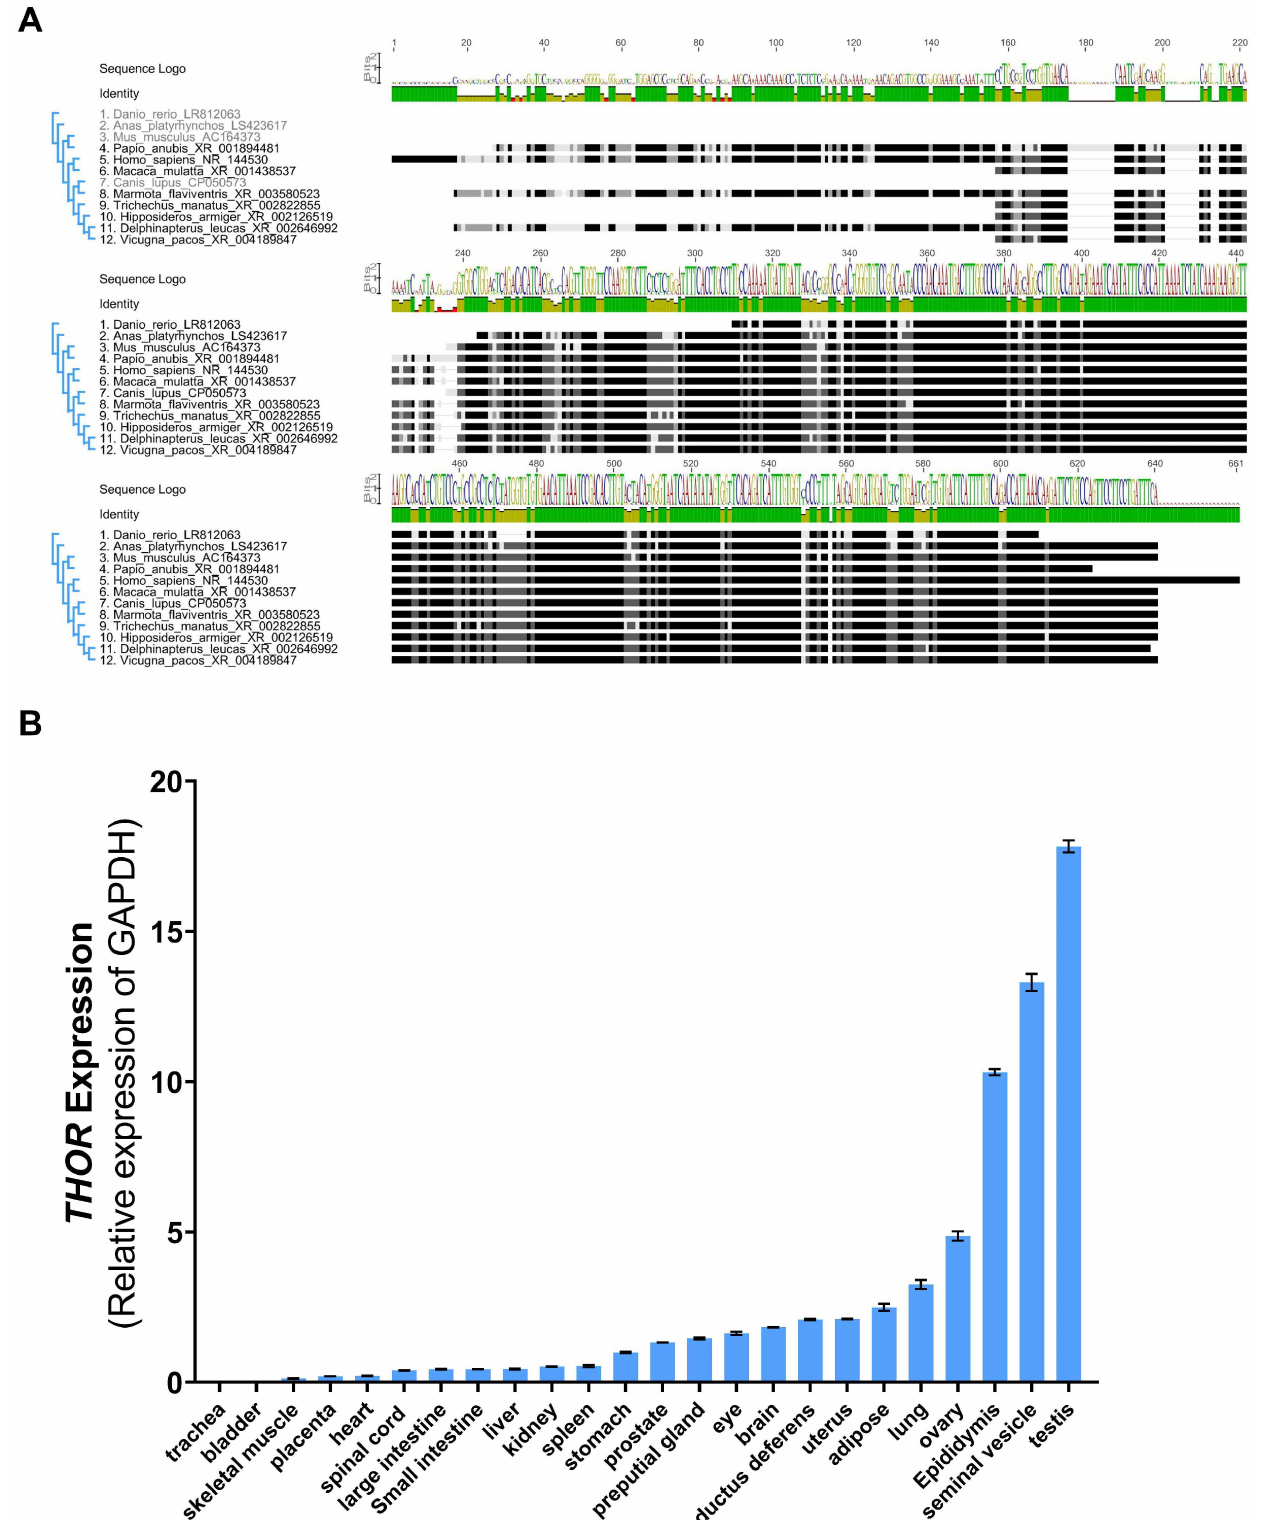
Figure 1. The evolutionary relationship and tissue conservation of THOR in vertebrates. ( A ) Sequence alignment of THOR in 12 representative vertebrates. ( B ) Measurement of mouse THOR expression by qRT-PCR in an adult murine tissue panel (data are shown as the mean ± SD from two independent